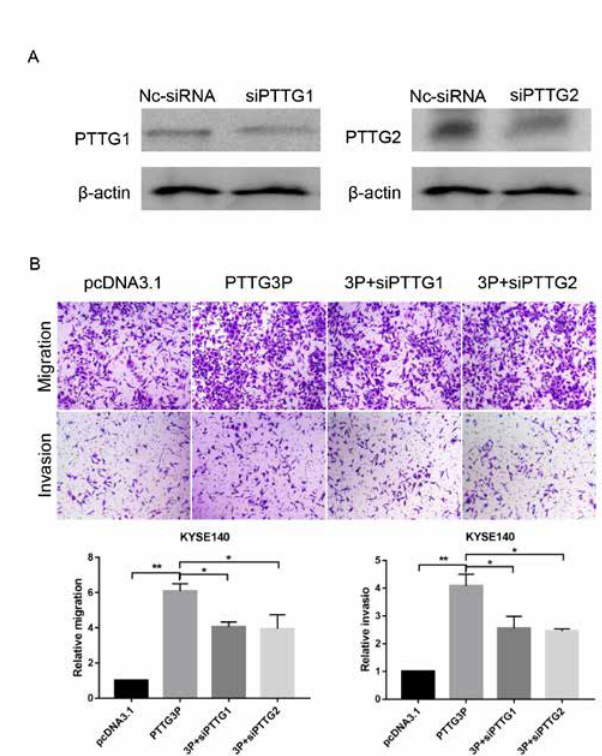
Figure 6: Effect of knockdown of PTTG1 and PTTG2 in PTTG3P-overex- pressing KYSE140 cells A. Protein expression levels of PTTG1 and PTTG2 in siRNA transfected KYSE140 cells were evaluated by Western blotting, β-actin was used as an internal control; B. Representative images (upper) and the number of migratory cells (down) per high-power field showed that knockdown of PTTG1 and PTTG2 partially attenuated the enhanced migratory and invasive ability of KYSE140 cells promoted by PTTG3P upregulation. Data are shown as the mean ± SD of three replicates; *P<0.05; ** by mediating PTTG1 and PTTG2 .